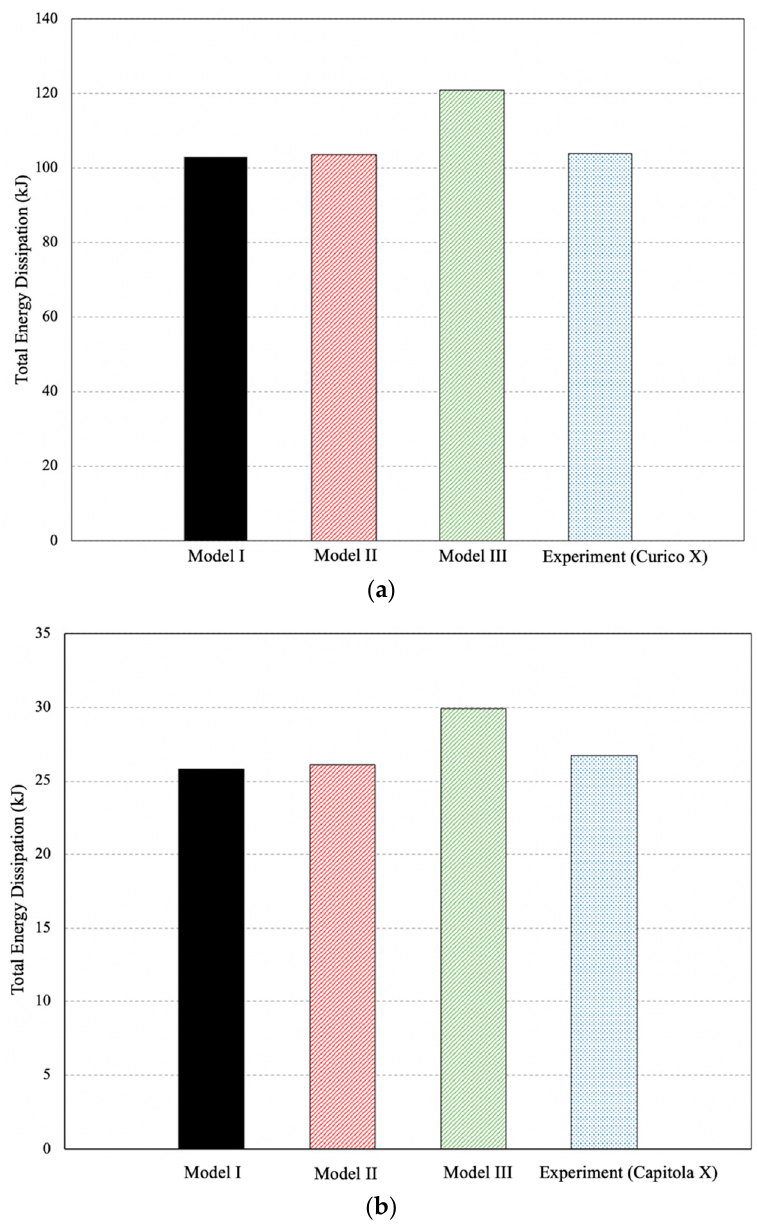
Figure 18. Energy dissipation comparison: ( a ) Curico X record; ( b ) Capitola X record.